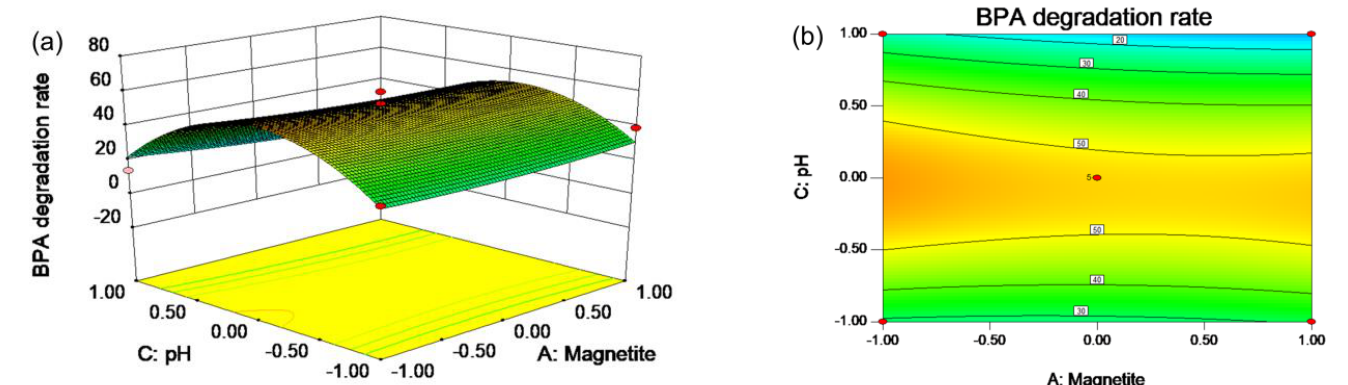
Figure 10. Response surface plot of pH and magnetite on BPA removal. (a) Three-dimensional plot; (b) Two-dimensional plot. [BPA] = 5 mg/L, [PS] = 0.2 mM, T =20 °C.